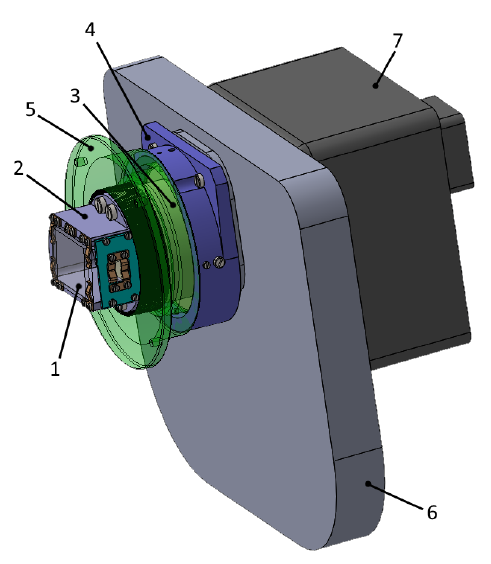
Figure 12. Opto-mechanical design of the slitless spectrograph unit: 1—grism, 2—grism mount, 3—connecting tube, 4—camera flange, 5—telescope mechanical interface, 6—telescope filter wheel, 7—telescope